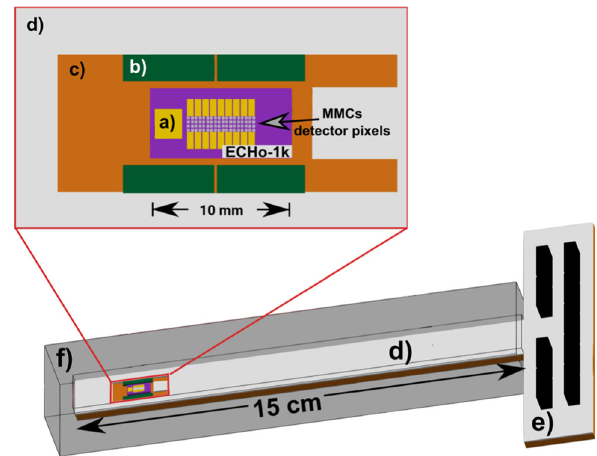
Fig. 2 Simplified design of the ECHo-1k experiment set-up used in the simulation. Inset: The region close to the ECHo-1k chip. On the purple-colored silicon ECHo-1k chip, 72 MMCs and large thermaliza- tionstructures( a )areplaced.NexttotheECHo-1kchip,fourdc-SQUID chips ( b ) are located. All five silicon-based chips are directly glued on the copper holder ( c ). A circuit board ( d ) covers the full copper holder, except the region next to the ECHo-1k chip. Connectors ( e ) are placed at a distance of about 15cm from the ECHo-1k chip. An aluminum